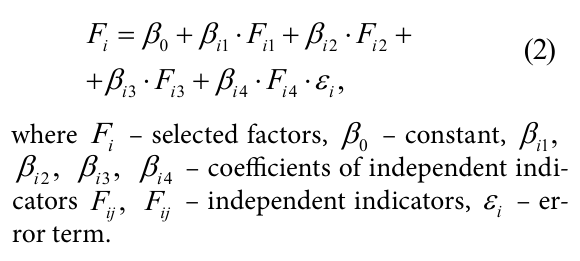
Table 1. Descriptive statistics of factors and their indicators